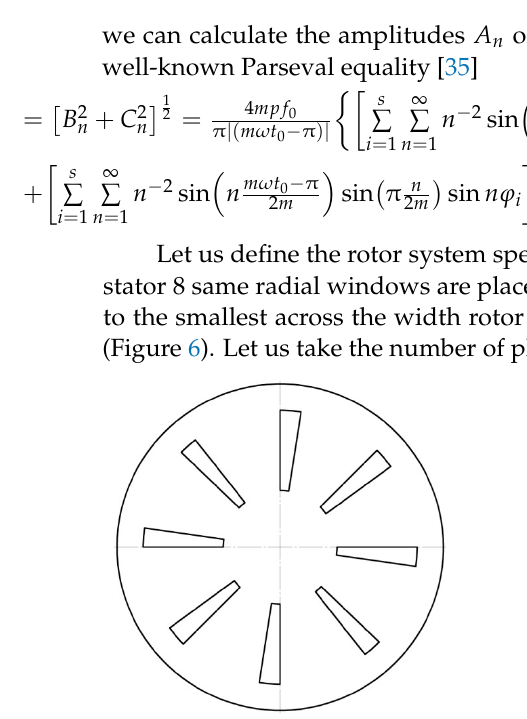
Figure 6. Placement of windows on the stator of the pneumatic system of the rotor type. We divide the rotor disk circular curve into 59 equal parts (number of places m =